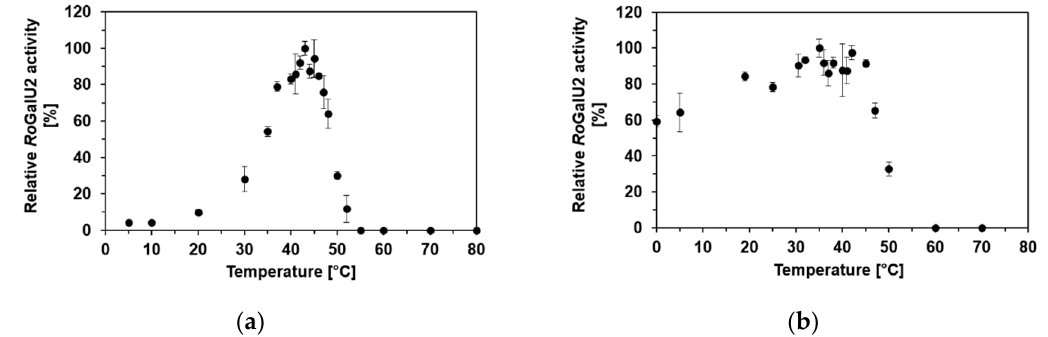
be concluded that magnesium is a crucial cofactor for the enzyme as presented in Scheme 2, respectively.